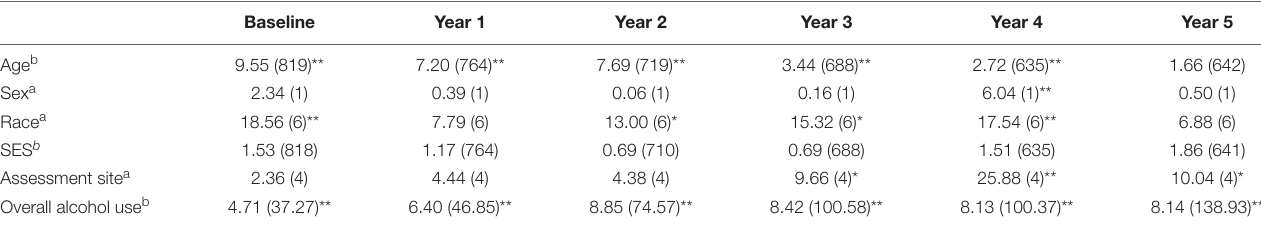
FIGURE 5 | Sample characteristics for participants reporting a past-year ARB history (ARB + participants). This figure describes ARB + participant sample characteristics for demographics and alcohol use frequency at baseline and each annual follow-up. The x-axis is defined as annual follow-up year in panels (A) through (F) . Panel (A) shows mean age of ARB + participants, panel (B) shows ARB + participants by sex, and panel (C) shows ARB + participants by race. Panel (D) depicts ARB + participants by median level of parental education, panel (E) depicts ARB + participants by assessment site, and panel (F) depicts past-year alcohol use frequency. TABLE 3 | Bivariate comparisons between ARB + and ARB − participant characteristics at baseline and each annual follow-up. Baseline Year